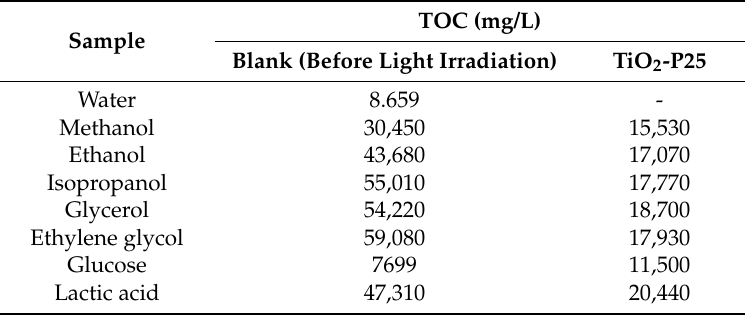
Table 2. TOC of solutions after the completion of the photocatalytic